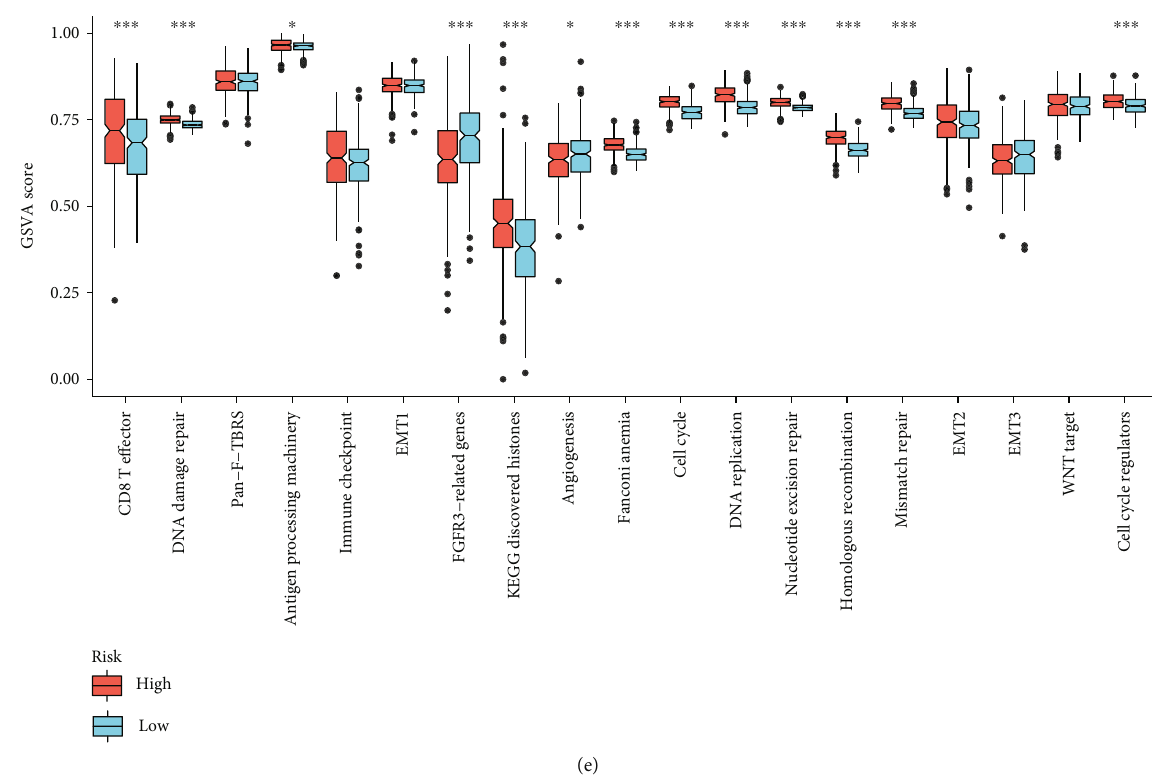
Figure 7: Biological state, process, and stemness features of the cuproptosis-relevant lncRNA signature. (a) Distribution of the variations of Hallmark gene set activity across low- and high-risk subsets. (b, c) Comparison of mDNAsi and mRNAsi between two subsets. (d) Correlations of risk score with the activity of known biological processes. (e) Comparison of the activity of known biological processes between two subsets. ∗ p < 0 : 05 ; ∗∗∗ p < 0 : 001